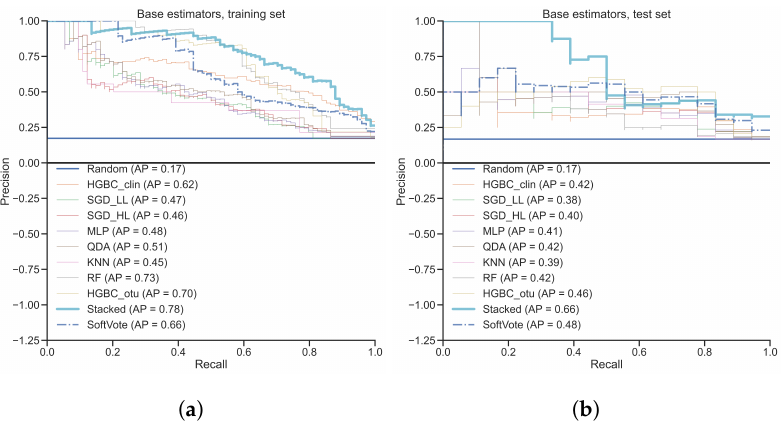
Figure A4. PR curves for stacked model applied on inflammatory bowel disease dataset with strict pre-filtering of microbial features. ( a ) Training set; ( b ) Test